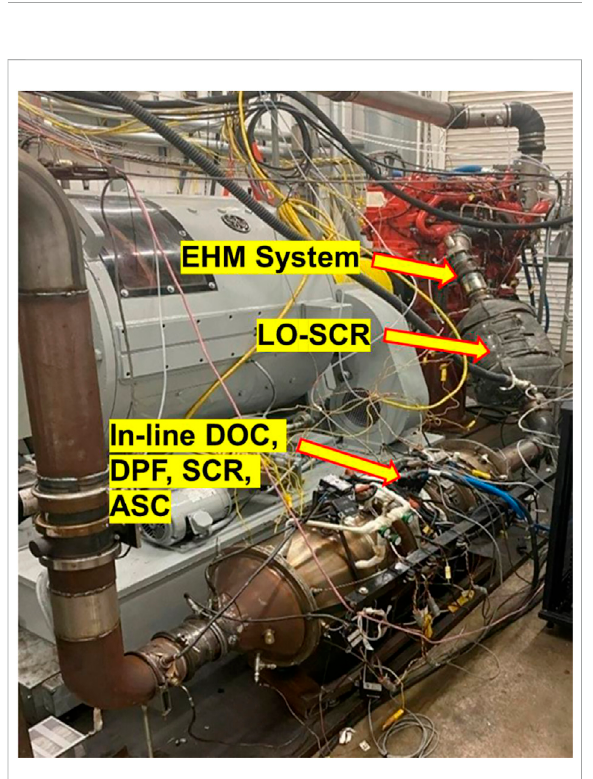
FIGURE 3 Engineandaftertreatmentsystem,includingEHMsystemand LO-SCR.